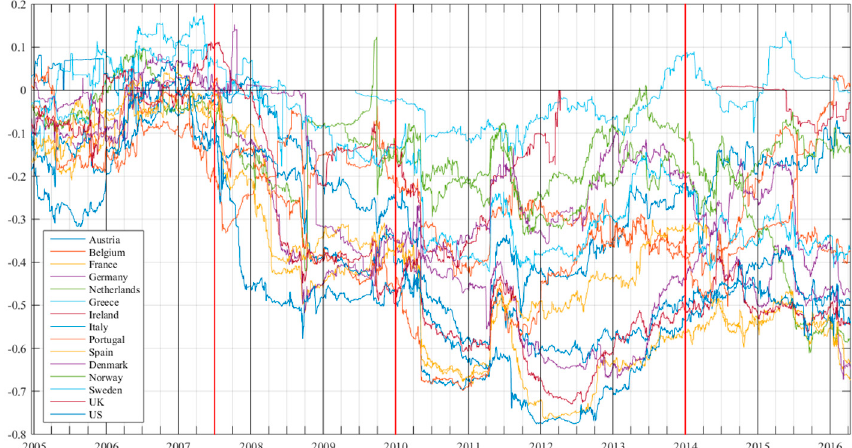
Figure 5. Daily time evolution of the correlation coefficients of the European and US stock index conditional volatility and CDS returns using 250-day rolling windows. The sample period is from 6 January 2004 to 12 April 2016. The vertical red lines mark the beginning of the different sub-periods: global financial crisis, Eurozone sovereign debt crisis and post-crisis period.